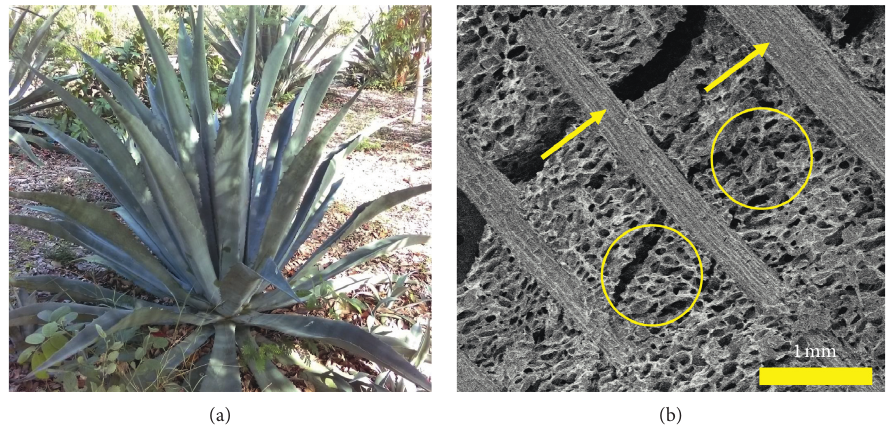
Figure 1: Agave plant (a) and a micrograph (own image) of the interior of the leaf showing the morphology of the fibers (arrows) and the parenchymal cells (circles)